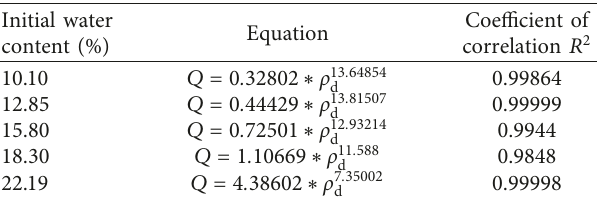
Figure 17: Relation of expansive stress and dry density with different initial water contents. Table 4: Fitting equations for the relationship of expansive stress and dry density.